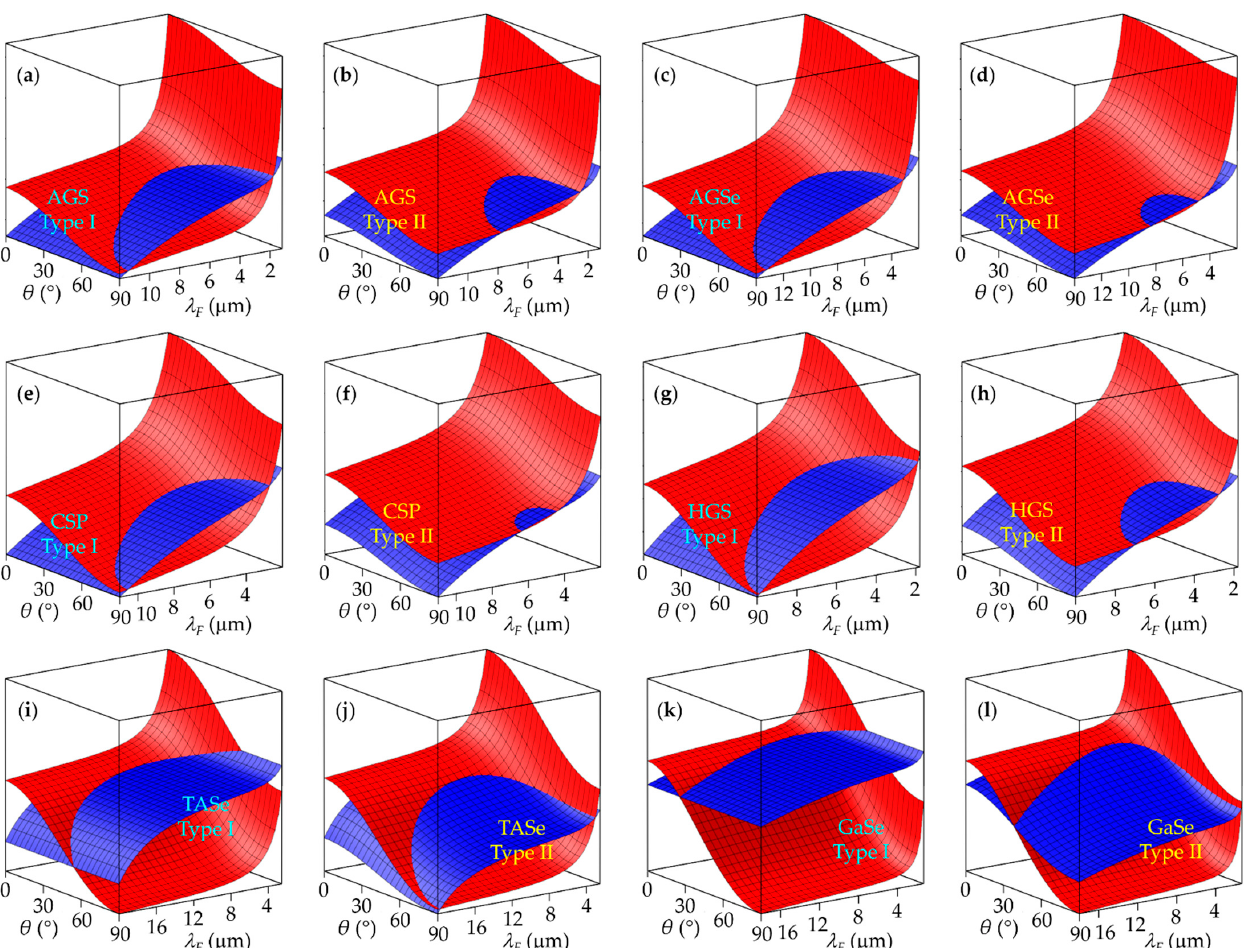
Figure 2. BPM properties of negative uniaxial crystals among chalcopyrite semiconductors and defect chalcopyrite exhibiting negative uniaxial birefringence: ( a ) Type I and ( b ) Type II in AGS; ( c ) Type I and ( d ) Type II in AGSe; ( e ) Type I and ( f ) Type II in CSP; ( g ) Type I and ( h ) Type II in HGS; ( i ) Type I and ( j ) Type II in TASe; and ( k ) Type I and ( l ) Type II in GaSe. The red and blue surfaces represent n e ( λ F /2, θ ) and n o ( λ F ) (for Type I) or 2 n e ( λ F /2, θ ) and n o ( λ F ) + n e ( λ F , θ ) (for Type II).